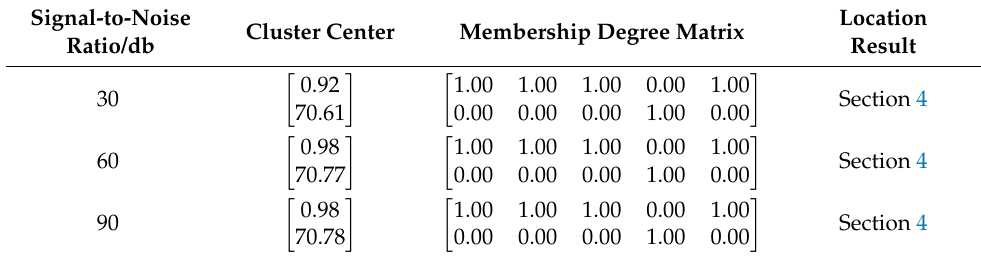
Table 5. Localization results under the influence of white Gaussian